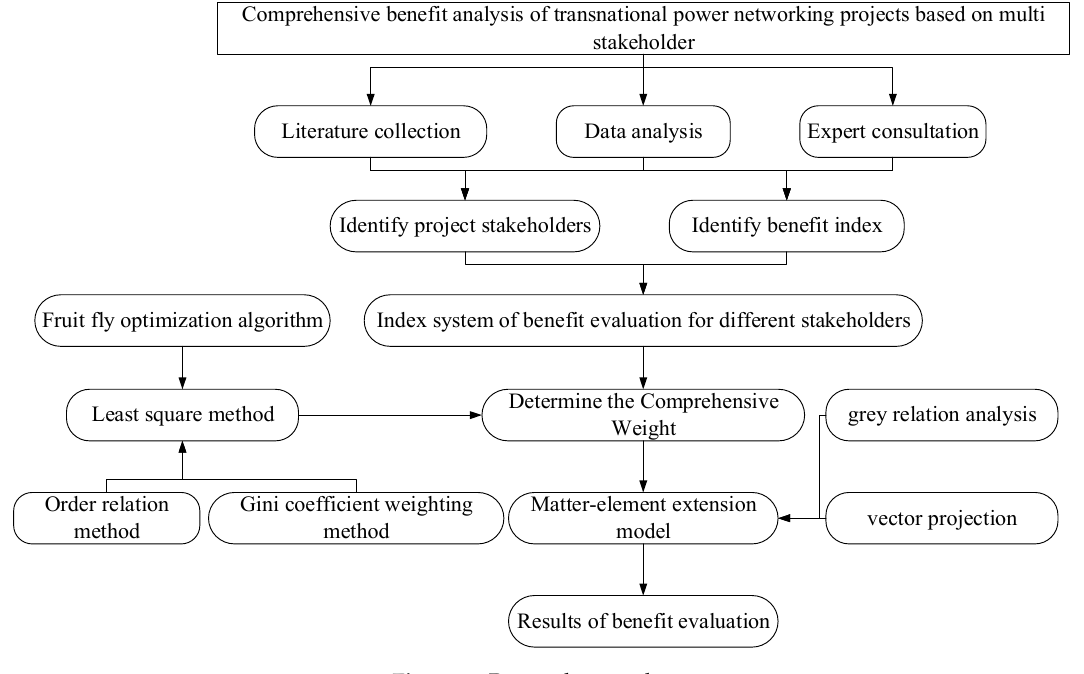
Figure 1. Research procedure.